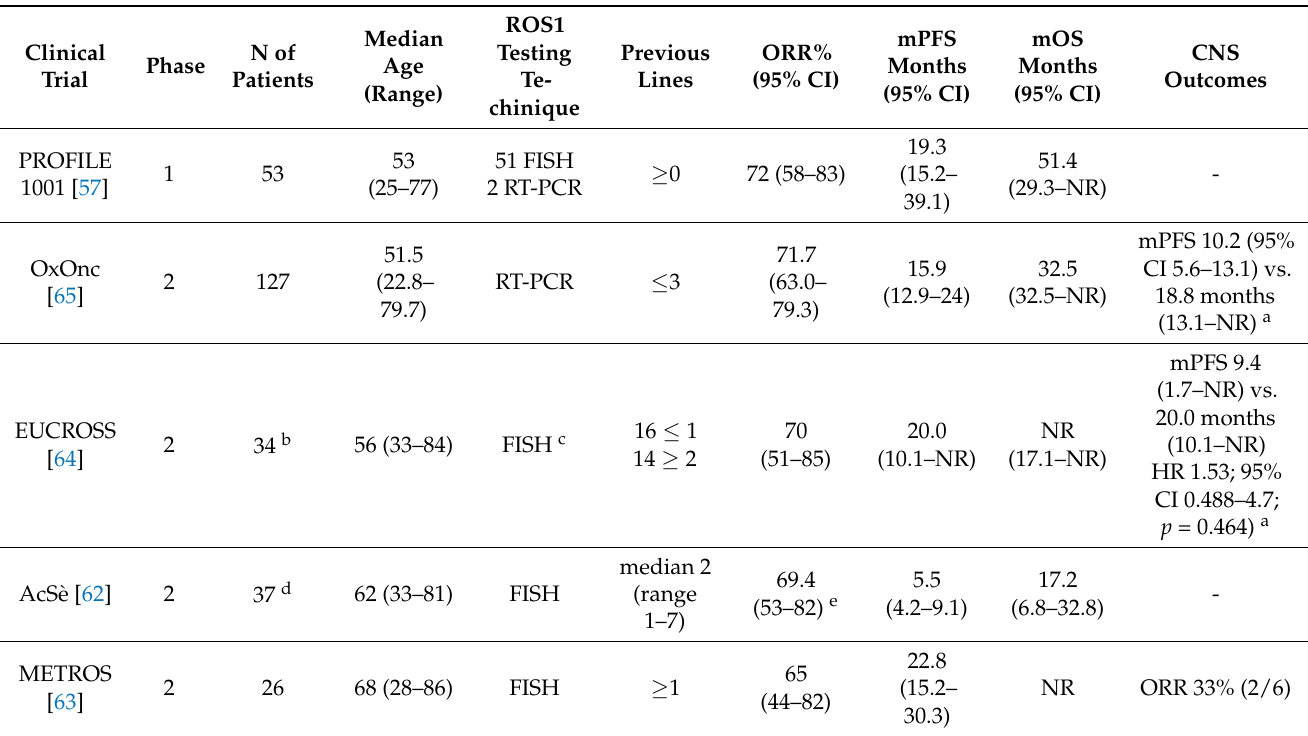
Table 2. Main prospective clinical trials with